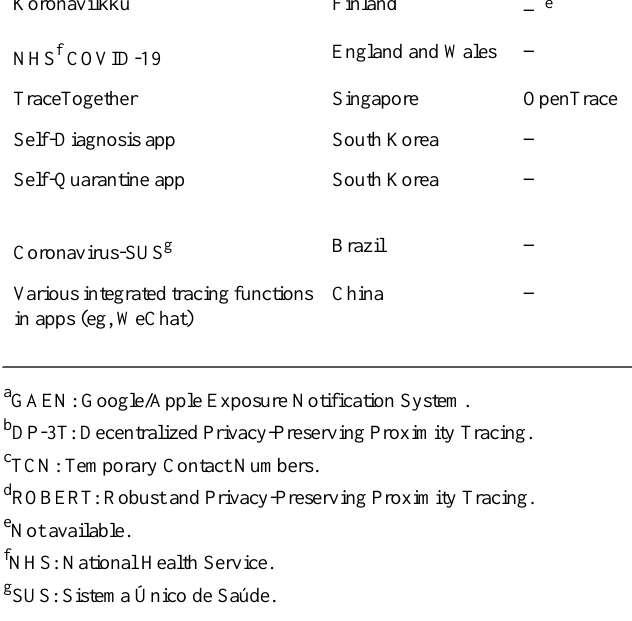
Interoperable with apps countriesGAEN a Tracing technologyProtocolCountryApp from other